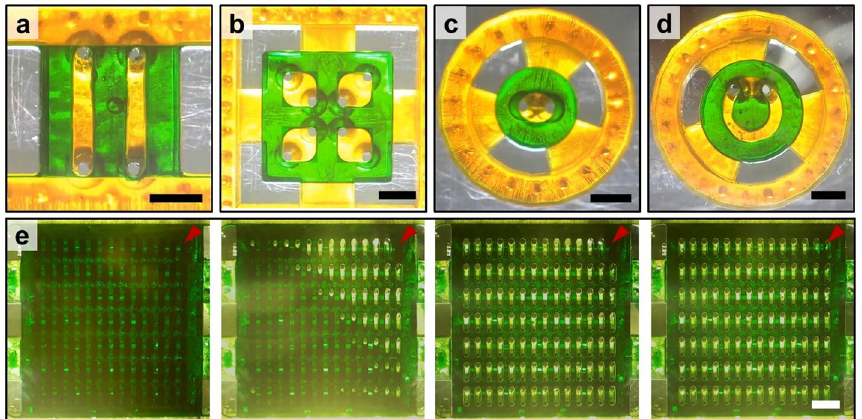
Figure 4. Bottom view images of devices with multiple microchannels with various shapes enclosed by green colored hydrogels. The channels are organized into ( a ) parallel lines, ( b ) a square lattice, ( c ) a circle, and ( d ) concentric circles. ( e ) Time-lapse images from left to right showing the generation of 98 channels via a single aspiration. Since the opposing hole directly beneath the aspirating hole (red arrow) has the smallest hole diameter, hydrogel solution under the channel containing the aspirating hole is removed last. All scale bars are 2